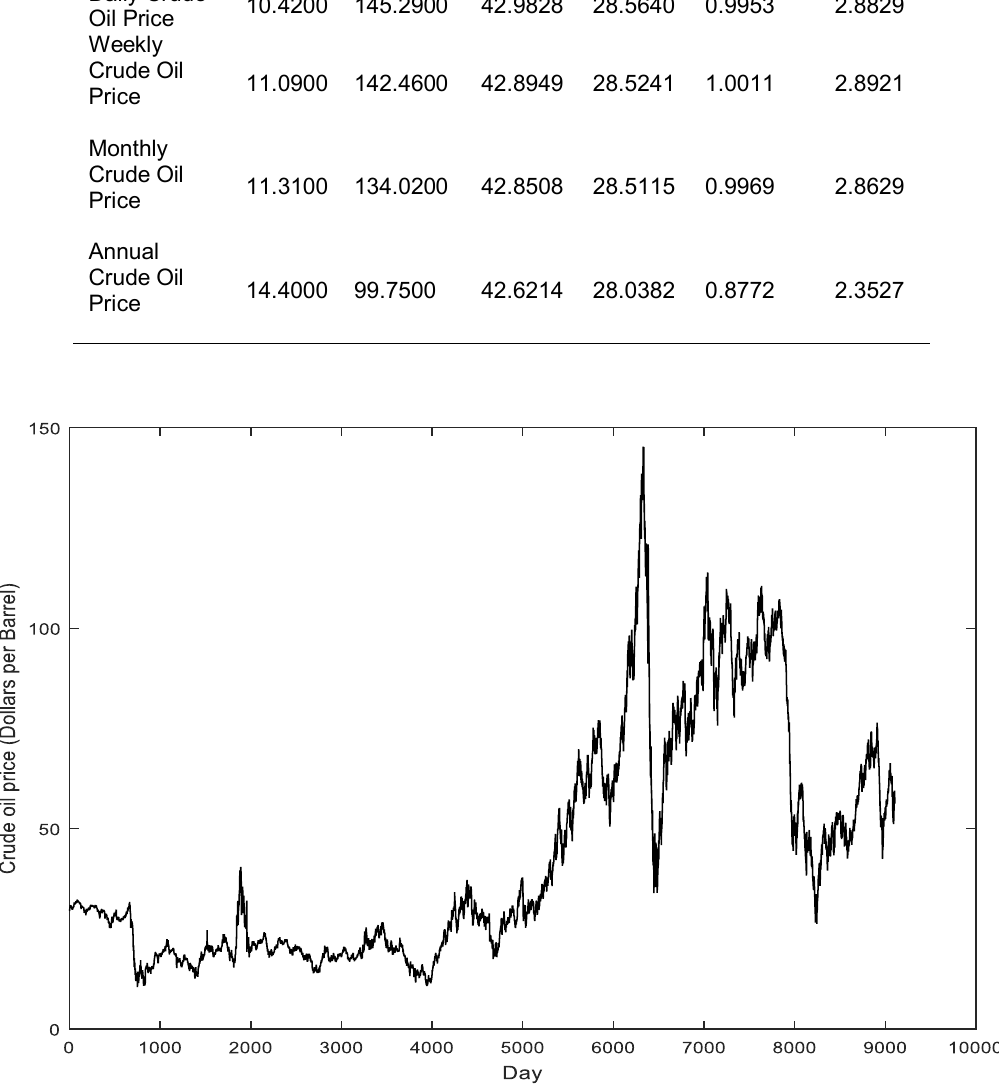
Figure 2. Daily crude oil price